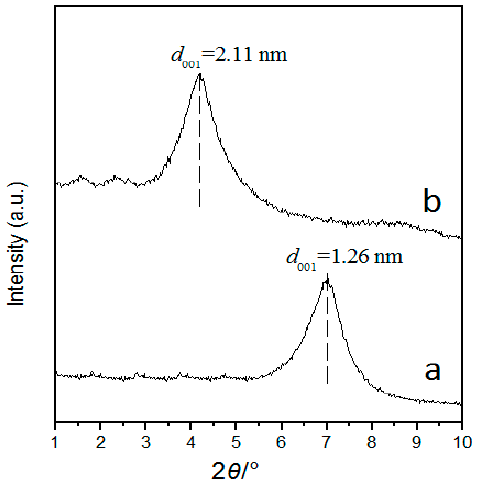
Figure 3. Small-angle X-ray diffraction (XRD) patterns. ( a ) Montmorillonite (MMT); ( b ) AlNi-PILC.